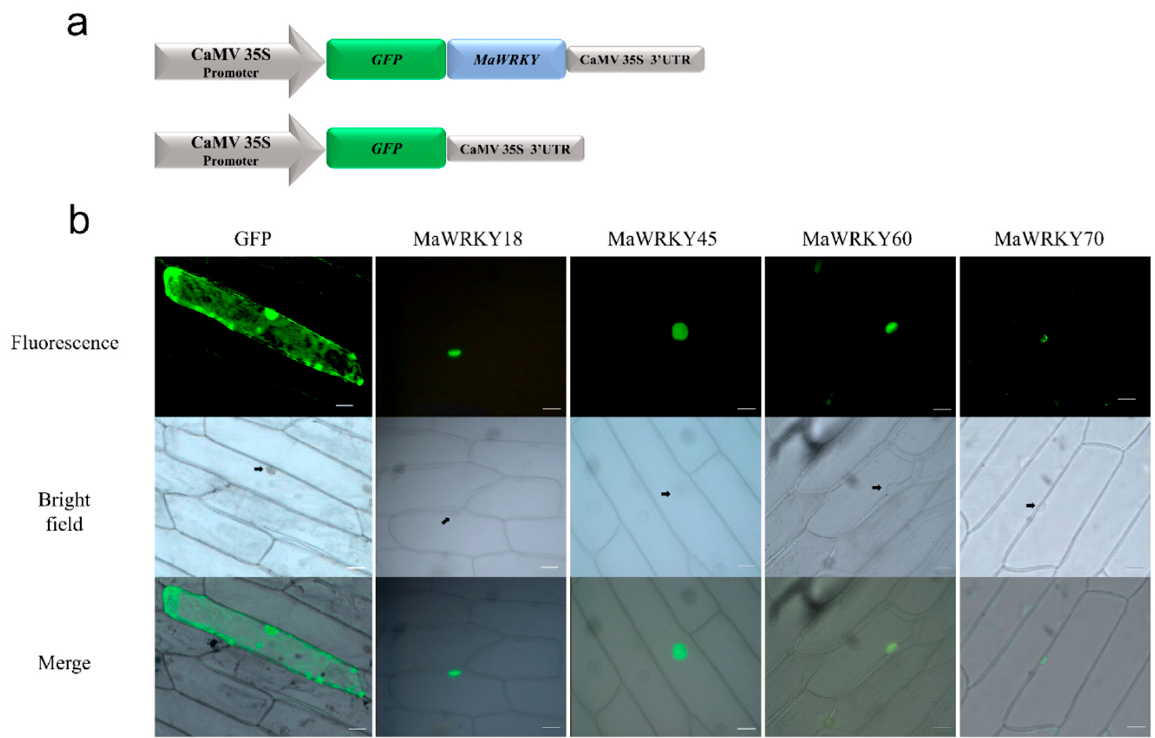
Figure 6. Subcellular localization of MaWRKY18, MaWRKY45, MaWRKY60, and MaWRKY70 proteins in onion epidermal cells. ( a ) Schematic representation of the expression cassettes used for the transient expression analyses. Gene expression is regulated by the CaMV 35S promoter and terminator present in the pAVA121 vector [40]. ( b ) The fluorescence of GFP fused with the MaWRKY proteins is localized in the nucleus, whereas the fluorescence of GFP alone used as a control is present in both the cytoplasm and nucleus. Scale bars: 5 µ